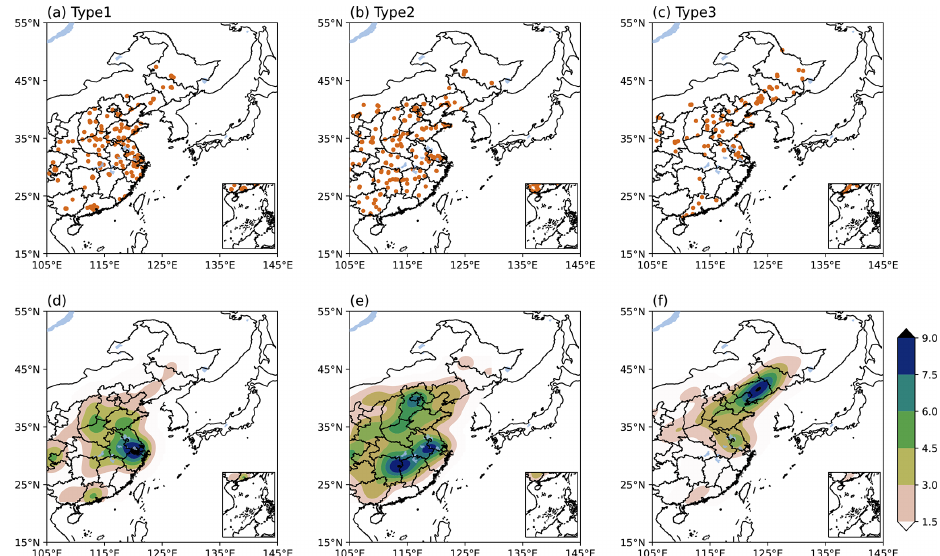
Figure 3. Distribution of stations dominated by (a) Type1, (b) Type2, and (c) Type3 synoptic circulation patterns. Weighted probability density distribution of stations dominated by (d) Type1, (e) Type2, and (f) Type3 synoptic circulation